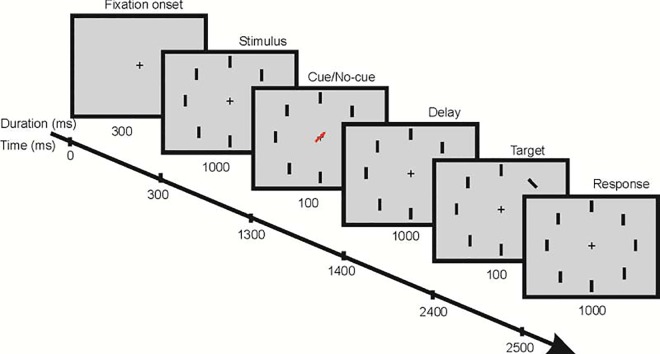
Illustration of the visual attention task.